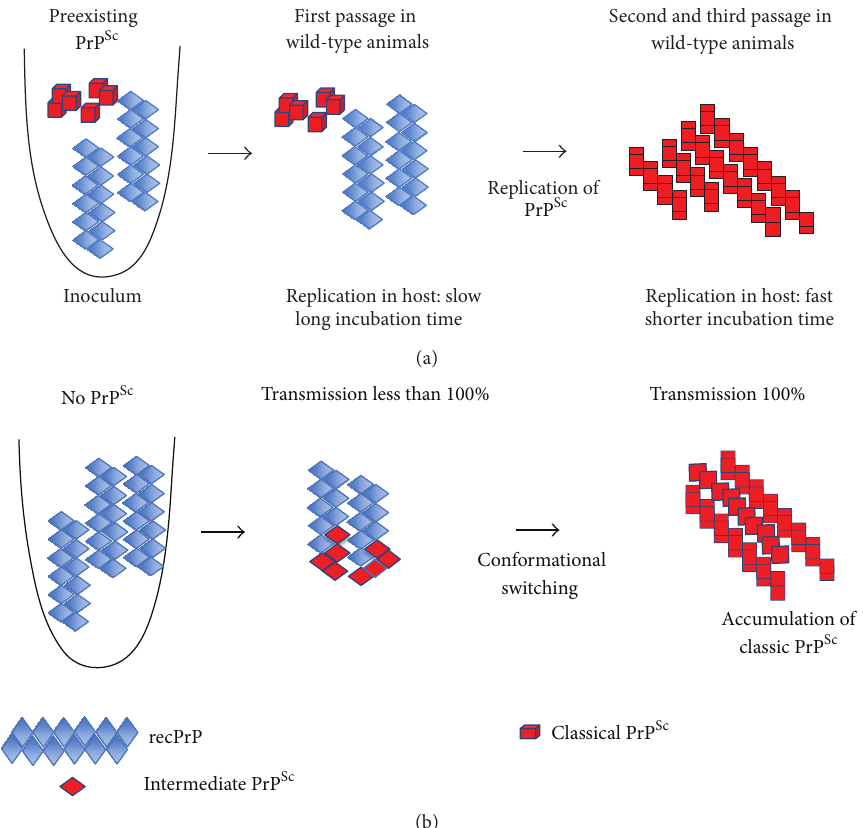
Figure 2: Schematic representation of two possible mechanisms of de novo propagation of prions from recPrP fibrils. (a) In this model, the preparation of recPrP fibrils contains very small amounts of classical PrP Sc . A long incubation time is required to amplify and propagate in vivo this minute amount of PrP Sc . (b) The second model (“deformed templating” mechanism) hypothesizes that there is no classical PrP Sc in the fibril preparation and that recPrP fibrils can be converted into PrPres (PrP Sc -like structures) with low efficiency. After several passages, these PrP Sc -like structures progressively adopt the structural features of classical PrP Sc . Schema adapted from Makarava et al., 2011